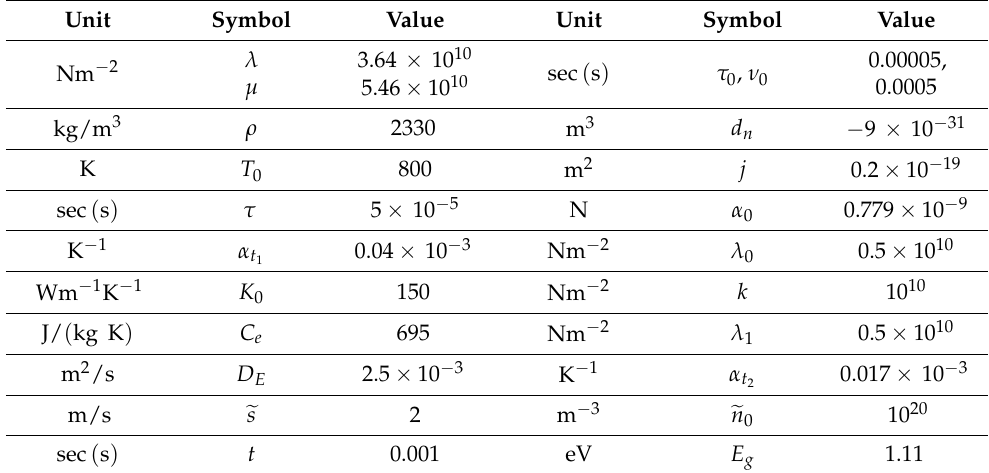
Table 1. The physical constants of Si material in SI